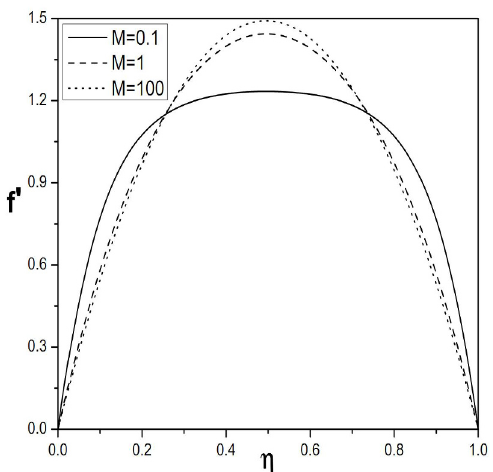
Figure 5. Effect of magnetic parameter M on normal velocity when Re = 0 . 2 .